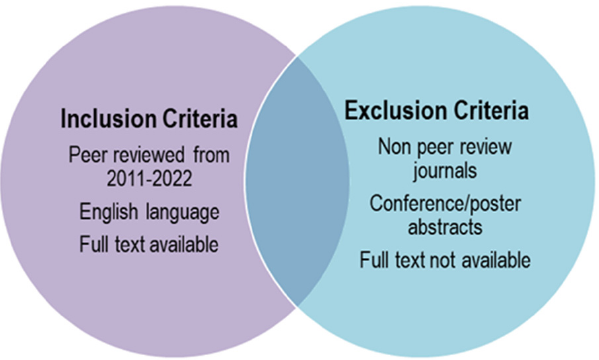
Figure 1. Inclusion and exclusion criteria on the systematic literature search .